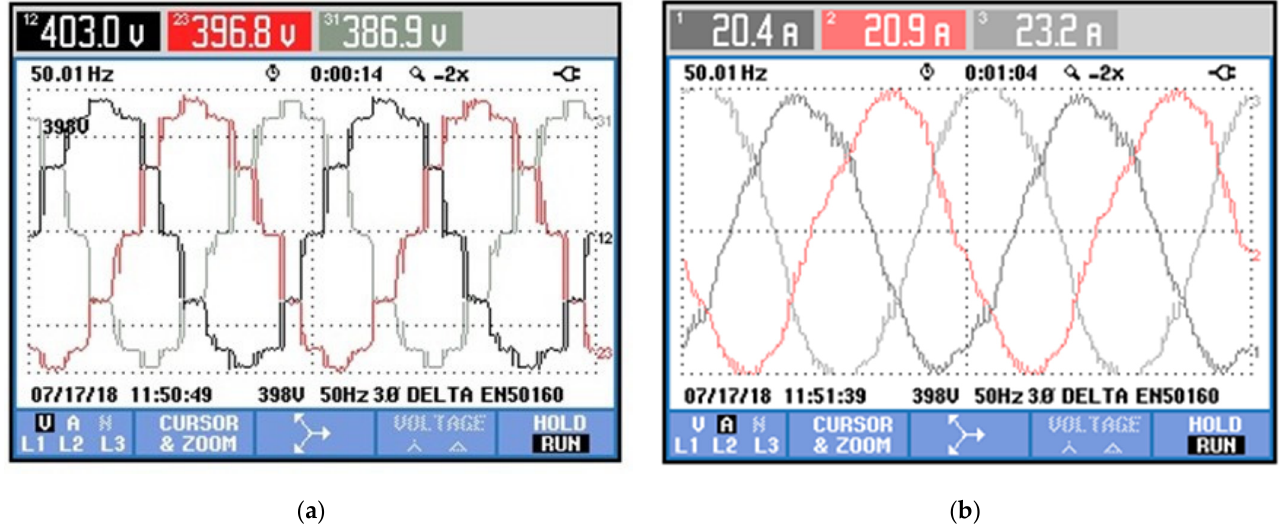
Figure 11. ( a ) AC Voltage offshore link grid generated result—FLUKE ® ; ( b ) AC Current result in the AC offshore link grid—CIS Control. AC offshore link grid—CIS